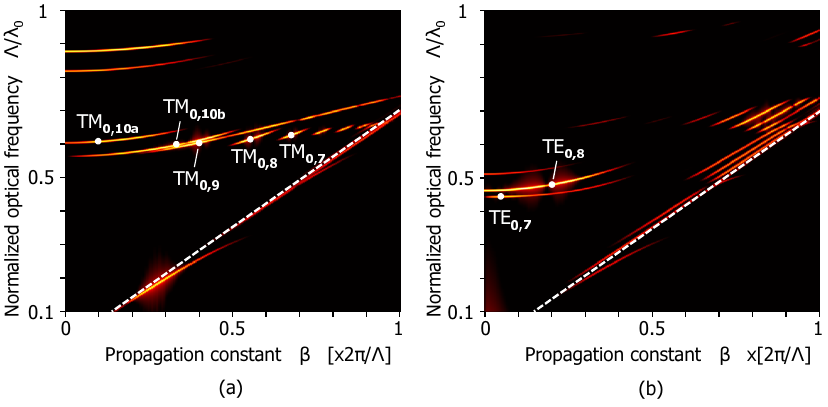
Figure 2. Dispersion relation of the sample fiber. ( a ) TM modes; ( b ) TE modes. White broken lines indicate the light lines of the cladding ( n =